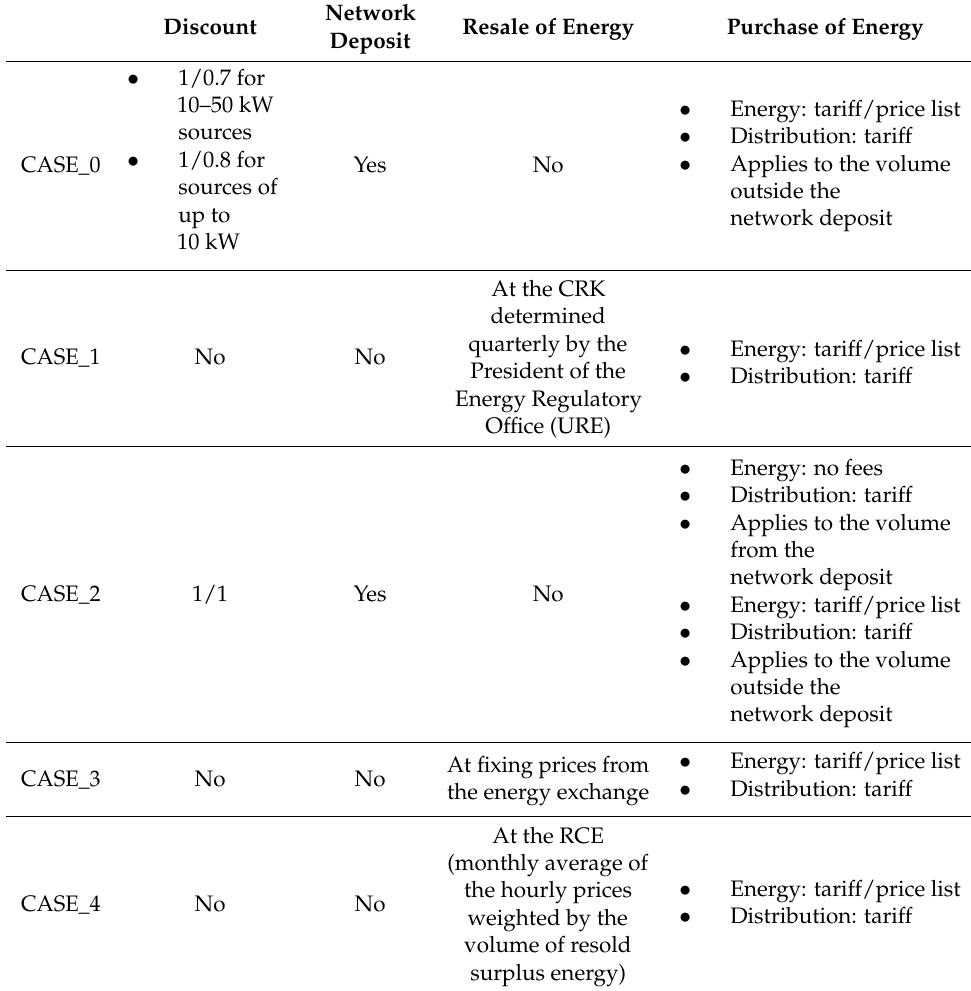
Table 1. Synthetic presentation of individual variants (scenarios) for